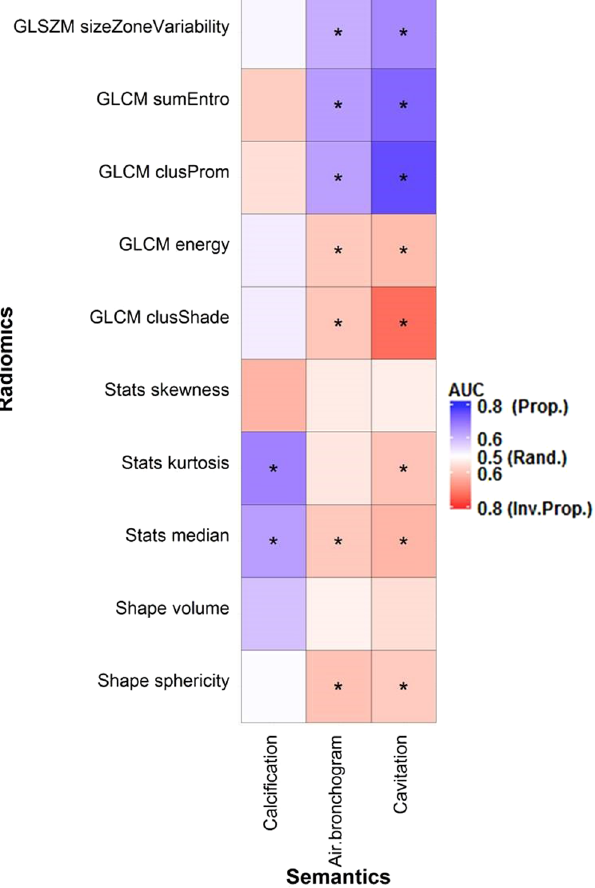
Figure 1. Association between the binary semantic and unfiltered radiomic features assessed with the area under the ROC curve (AUC). * Indicates a significant association (q-value ≤ 0.05). “Rand.” = random association (AUC = 0.50). “Prop.” and “Inv. Prop.” indicate direct and inverse proportionality,